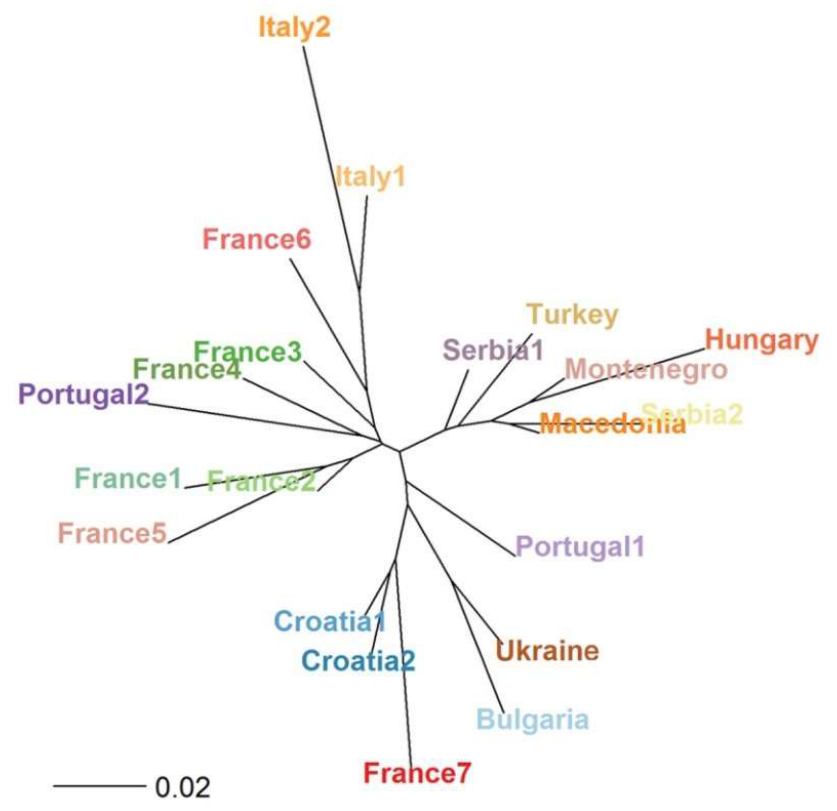
Figure 3. Neighbor-joining (NJ) tree based on population pairwise fixation index. Genetic distances were computed among populations grouped based on sampling locations.